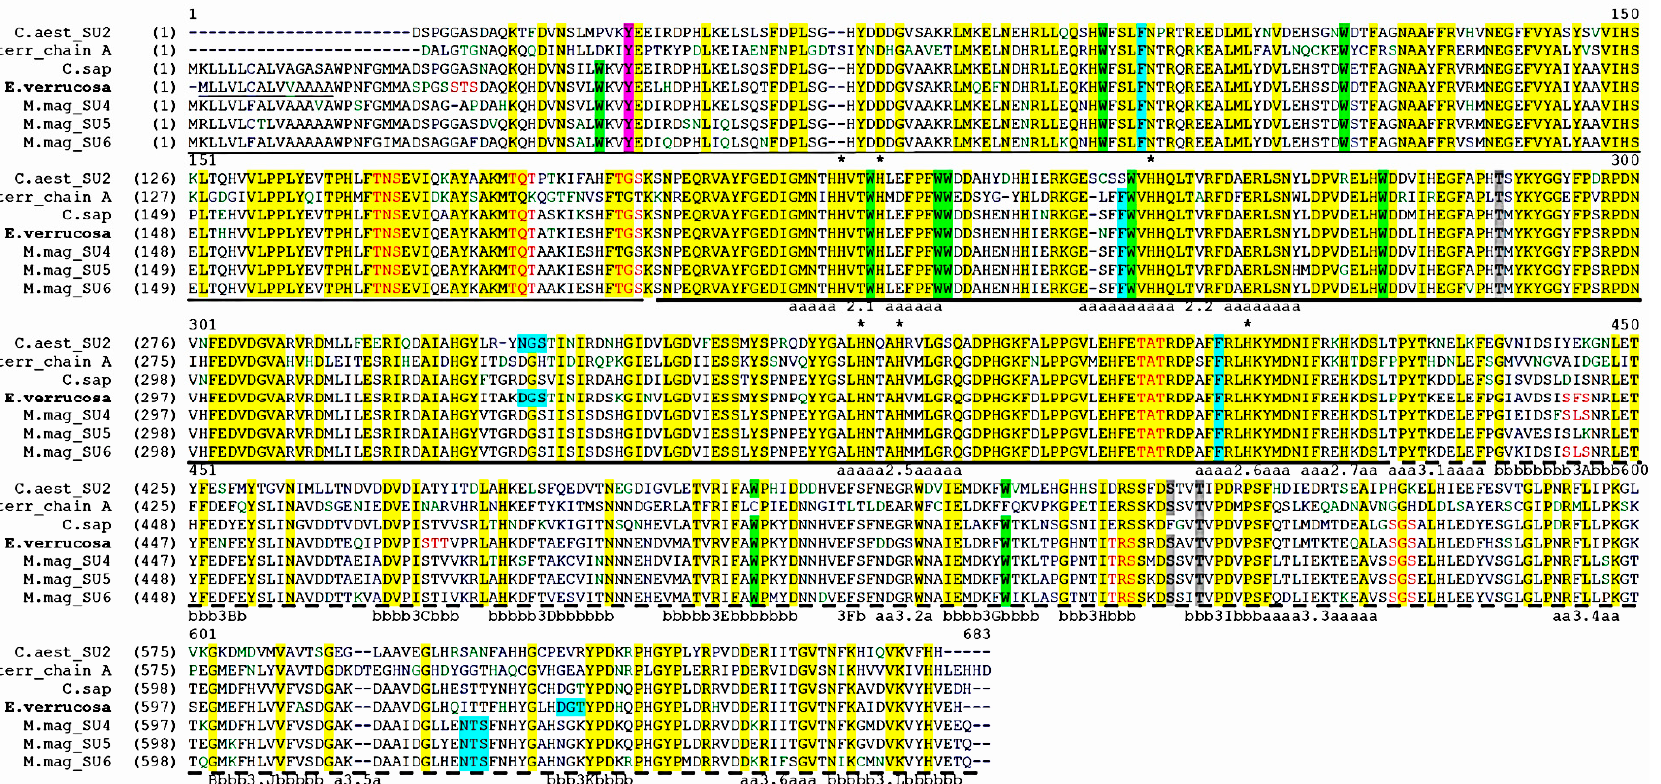
Figure 3. Multiple alignment of EvHc5 with the sequences of the hemocyanin subunits isolated from crustacea species belonging to suborders Dendrobranchiata and Pleocyemata of the order Decapoda, class Malacostraca. The proposed signal peptide is represented by 14 amino acid (underlined). The conserved residues are highlighted in yellow; the copper-binding histidine residues are shown with asterisks; the conserved phenylalanine (F) with turquoise color; the tryptophan (W) residues with green color; N-glycosylation sites are highlighted in turquoise and the O-glycosylation sites are marked with red letters. The structural elements ( α -helices and β -strands) were derived and numbered according to the 3D structure of P. interruptus Hc [16]. Domain borders are shown according to [24] as follows: Domain 1—thin black line; Domain 2—thick black line; and Domain 3—dashed line.